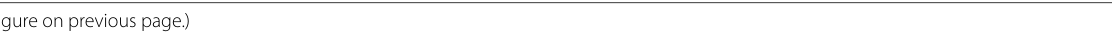
filter(See figure on previous Fig. 1 Seismic stations and hypocenters used in this study and example of waveform on transverse component at DP.YGI. a Gray dots represent hypocenters. Red and green triangles represent temporary and permanent seismic stations, respectively, of Kyoto University, AIST, NIED, and JMA. Blue stars represent hypocenters of deep low-frequency earthquakes (DLFs). Black lines indicate the location of active faults. Green lines show the depth contours of the upper boundary of the Philippine Sea plate reported by Hirose et al. (2008). b In the inset map, the black star and circle represent the hypocenter of a M2.0 earthquake on March 8, 2010, and seismic station (DP.YGI), respectively. This waveform is unfiltered by a 5–8-Hz band-pass